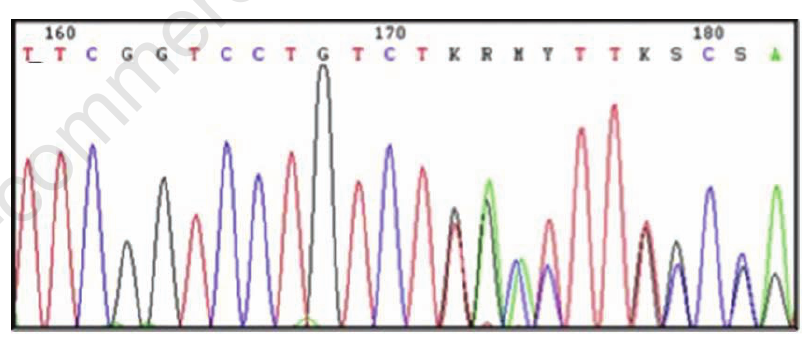
Figure 2. A) Electrocardiogram recording on admission, with ventricular fibrillation episode triggered by ventricular extrasystoles (arrow). B) Fluoroscopy-guided radiofre- quency ablation of the ventricular focus triggering the VF episodes. RA, right atrium; RV, right ventricle; ABL, ablation catheter.